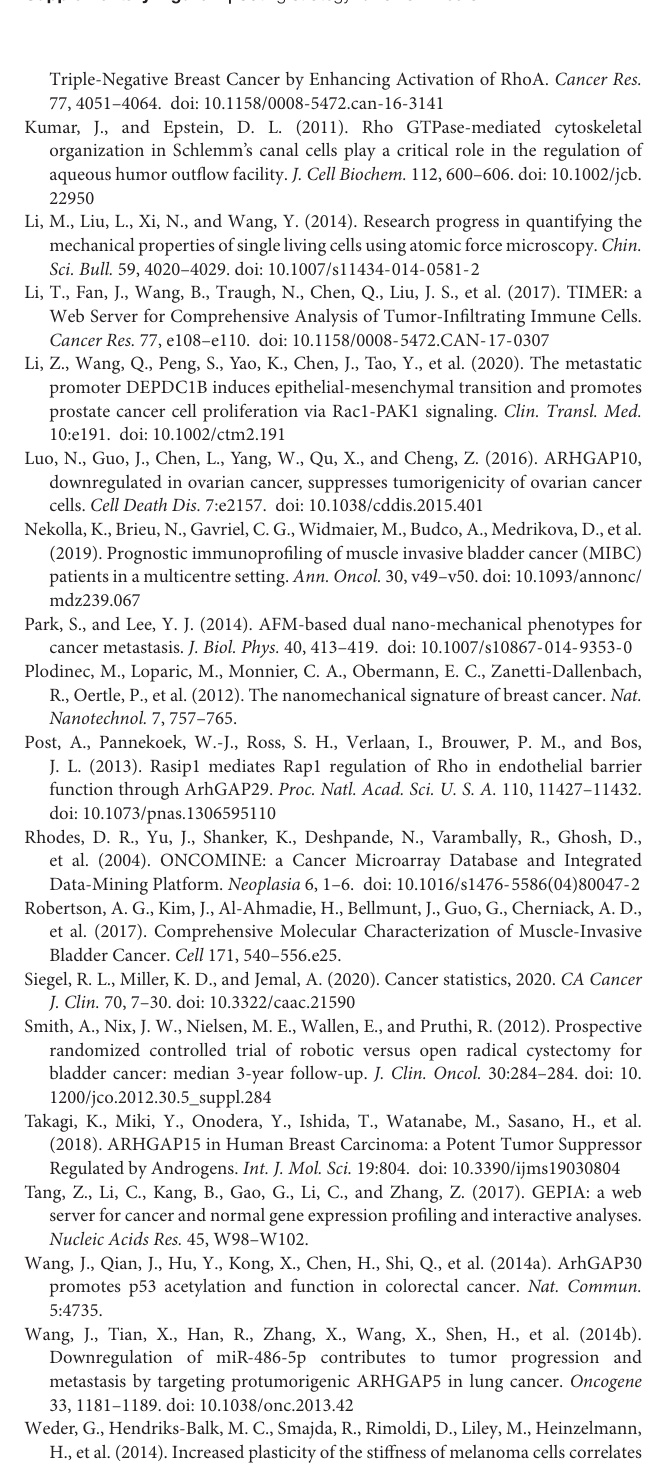
Supplementary Figure 3 | Correlations between prognosis related ARHGAP family gene associated immune cell infiltration. (A) Immune infiltration correlation with ARHGAP8, ARHGAP11A, ARHGAP37, and ARHGAP38 in TCGA-BCa samples were carried out by TIMER. (B) Boxplots were used to visualize ARHGAP family associated certain cell type enrichment scores and logarithm transformed immune scores, stroma scores, microenvironment scores of different groups through xCell analyzed TCGA samples in BCa. (C) ARHGAP family associated infiltration of CD8+ T cells, CD4+ T cells, type 1